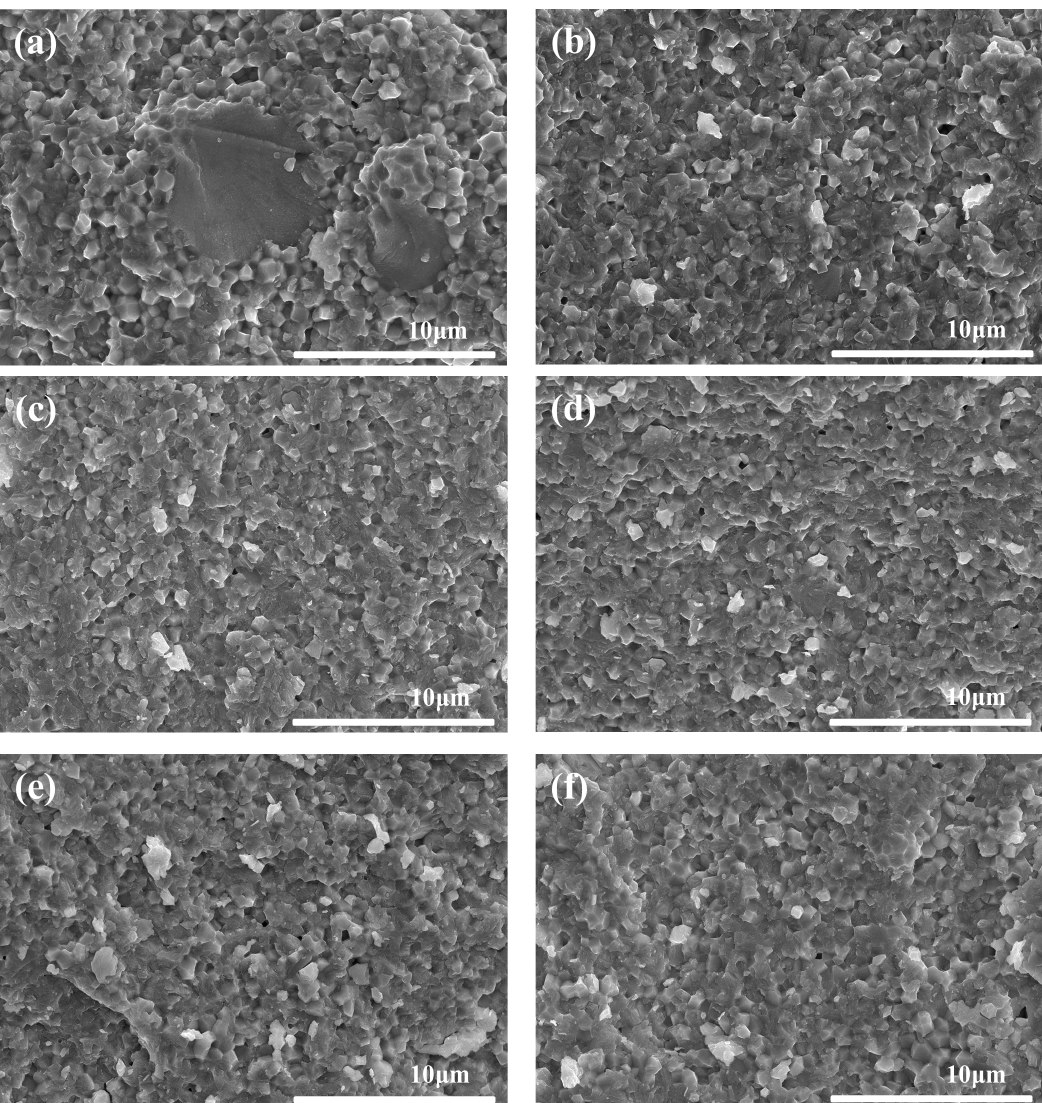
Figure 8. Fractural morphologies of the sintered samples with different coupling media at 1575 °C for 2 h. ( a ) sample A, ( b ) sample B, ( c ) sample C, ( d ) sample D, ( e ) sample E, and ( f ) sample F.